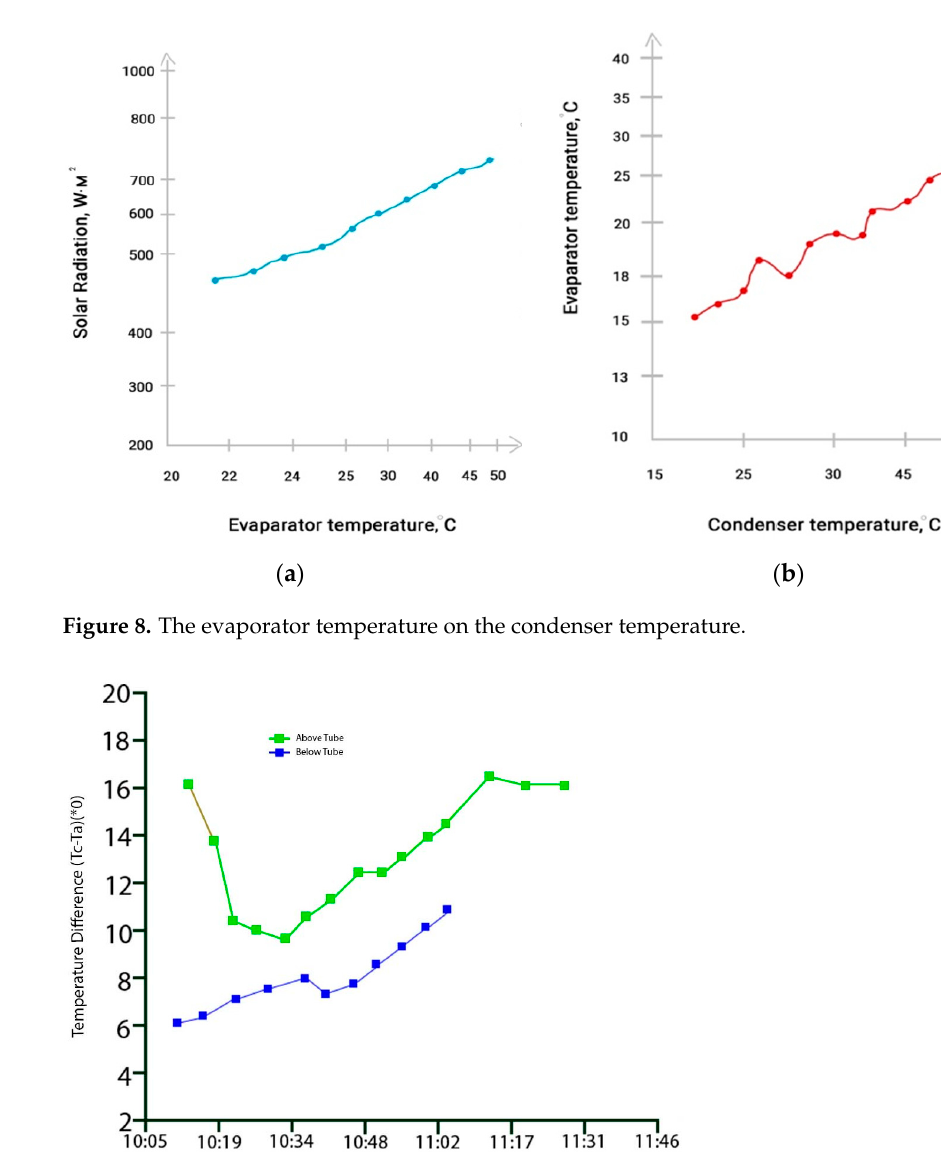
( b ) Figure 7. Changes in the efficiency of the collector: ( a ) the pitch of the tubes; ( b ) the thickness of the absorbing plate. Figure 8a,b shows the effect where with a rise in the evaporator temperature, the